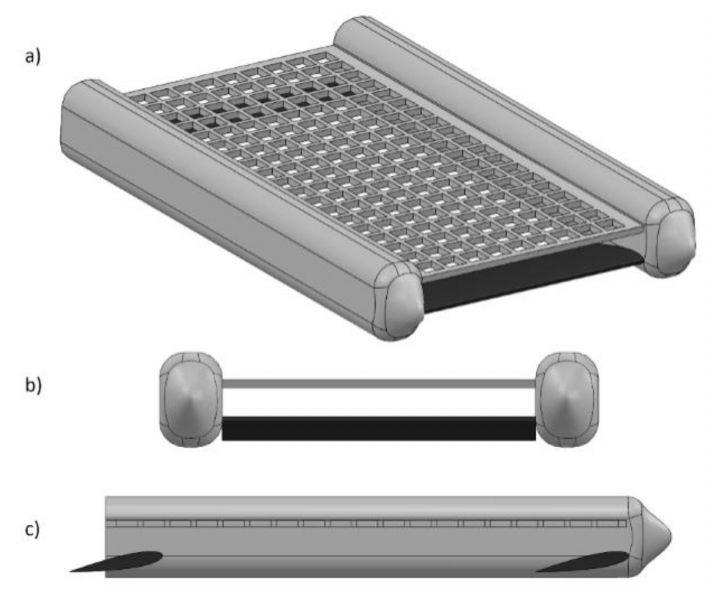
Figure 10. Simplified model for fluid-dynamic analysis (angle of attack: 10 ◦ ). ( a ) Isometric view. ( b ) Frontal view. ( c ) Lateral cross section view.